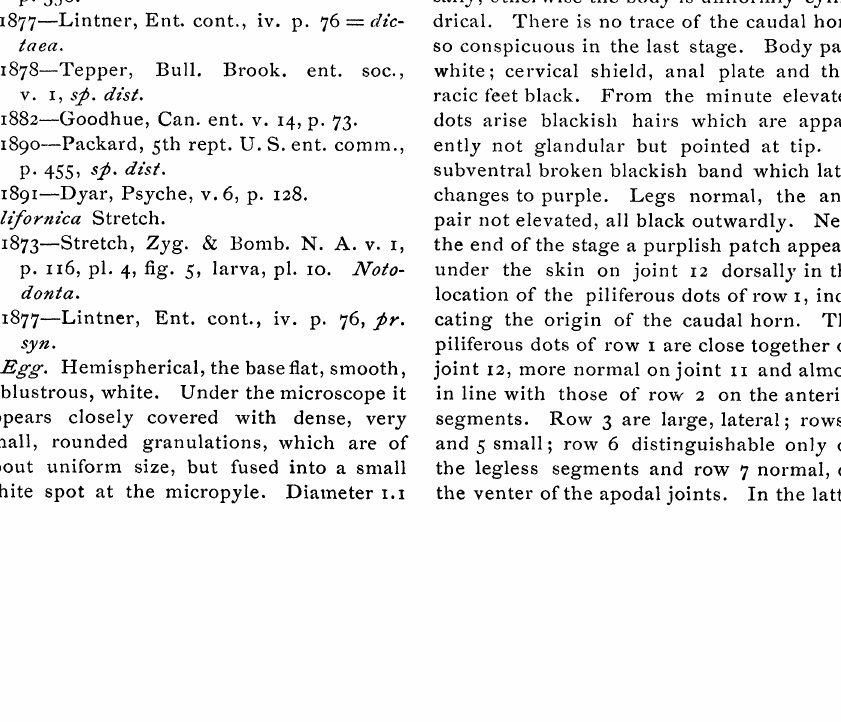
p. 66, fig. 515, Orymonia. 1882--Grote, New check list, p. I9, Pke- osia. rimosa Packard.